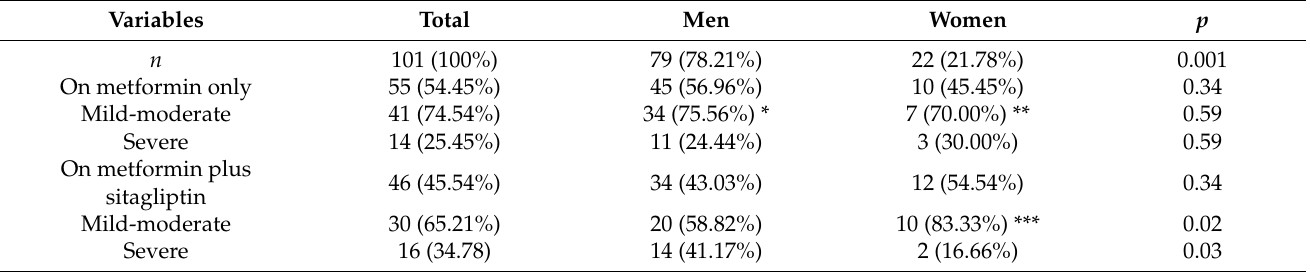
Table 4. Gender difference and COVID-19 severity regarding metformin or metformin plus